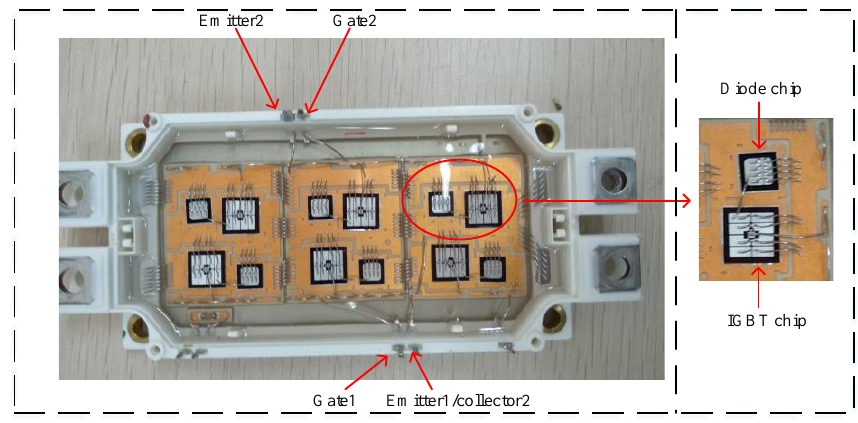
Figure 2. The opened IGBT module.